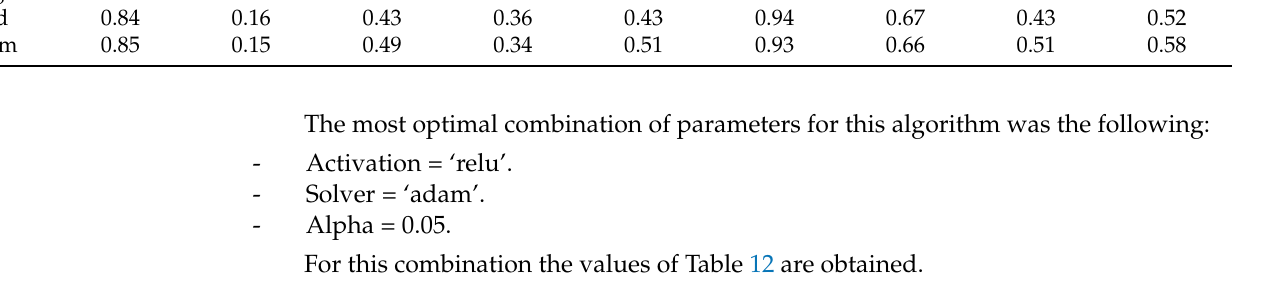
Table 12. Metrics evaluated for Neural Network.